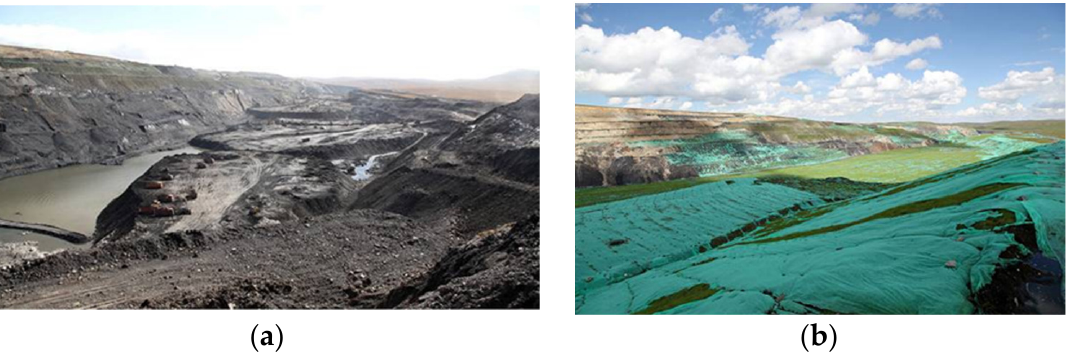
Figure 2. The Muli mine area before and after reclamation in 2020. ( a ) Mining area in August 2020, ( b ) filling and forest recovery after August 2020.